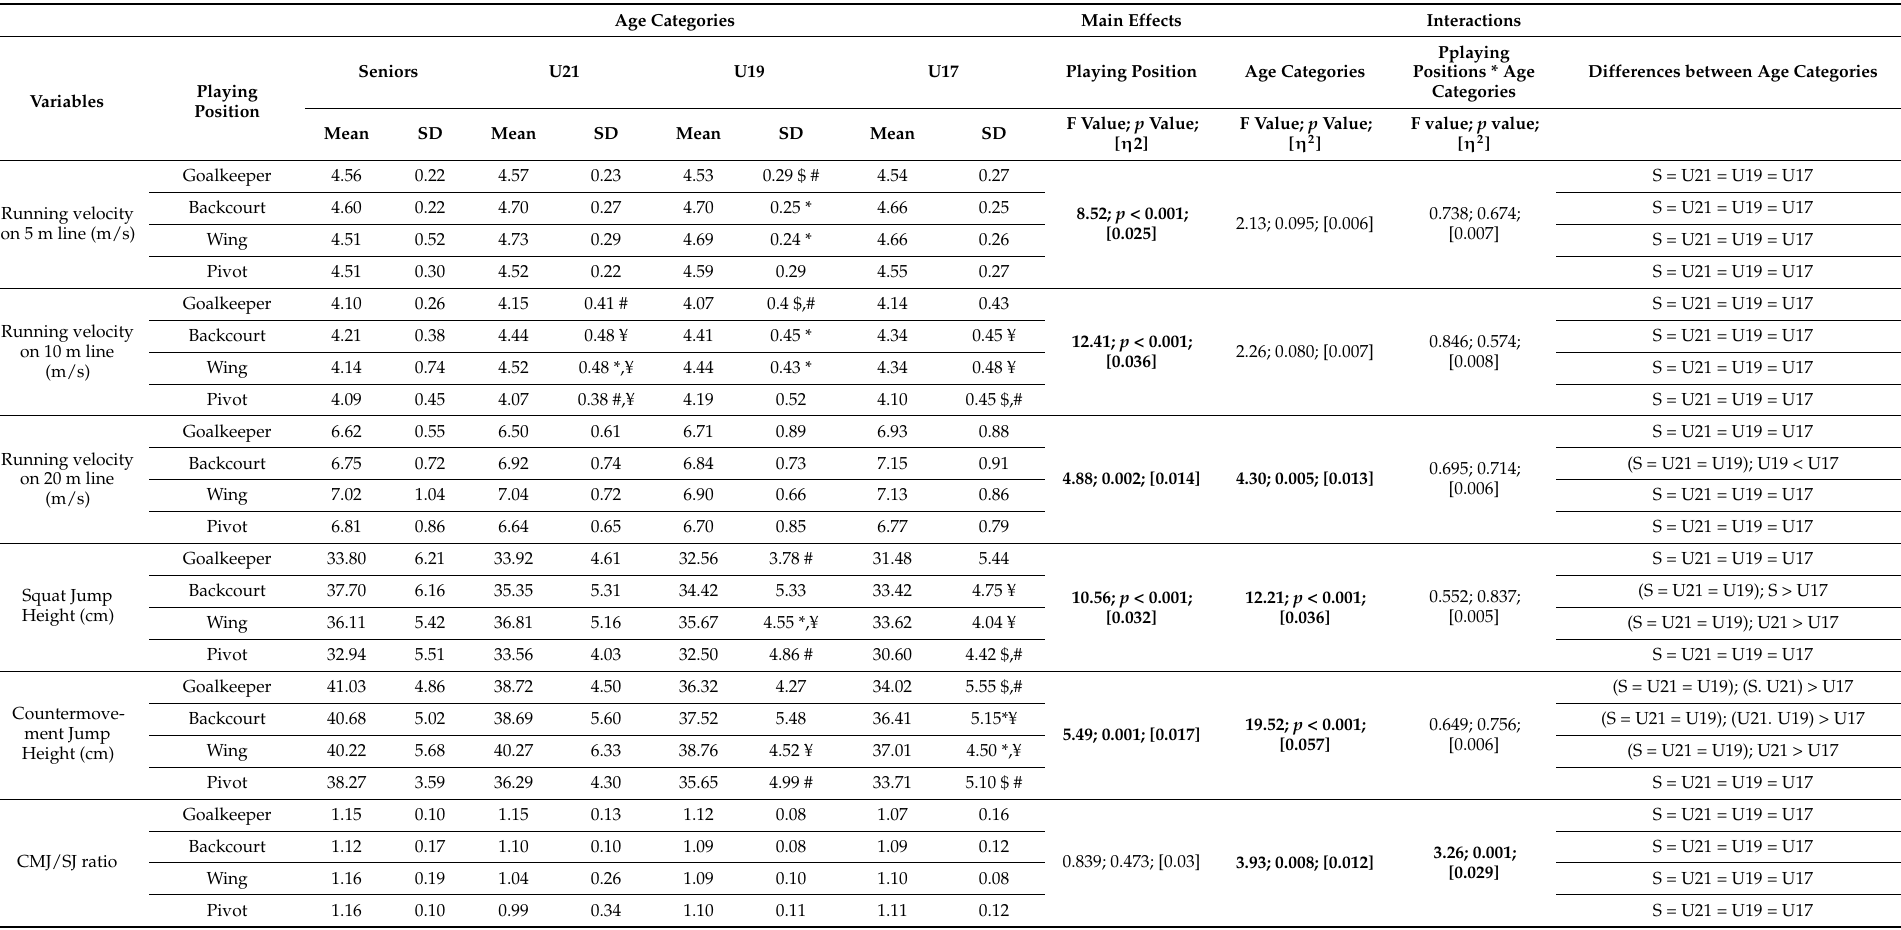
Table 3. The sprinting and power performance profile of elite handball players based on age category and playing